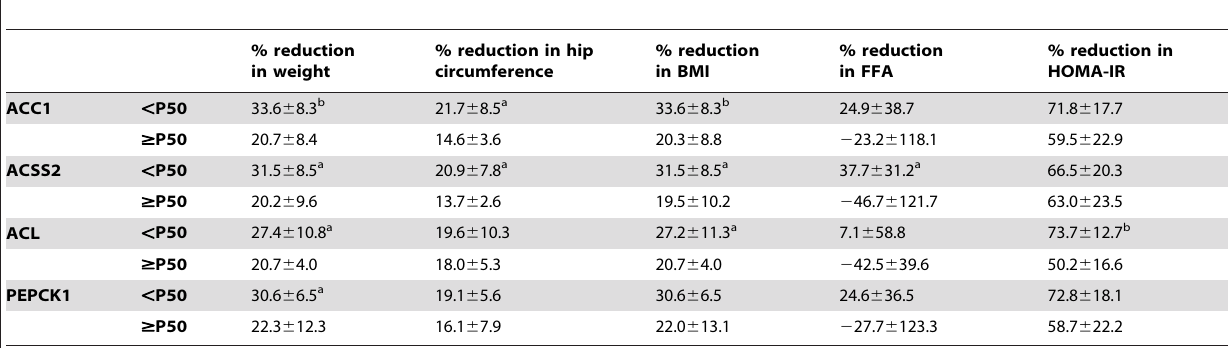
Table 3. Reduction in the anthropometric and biochemical variables according to the 50 th -percentile of the expression of different genes in subcutaneous adipose